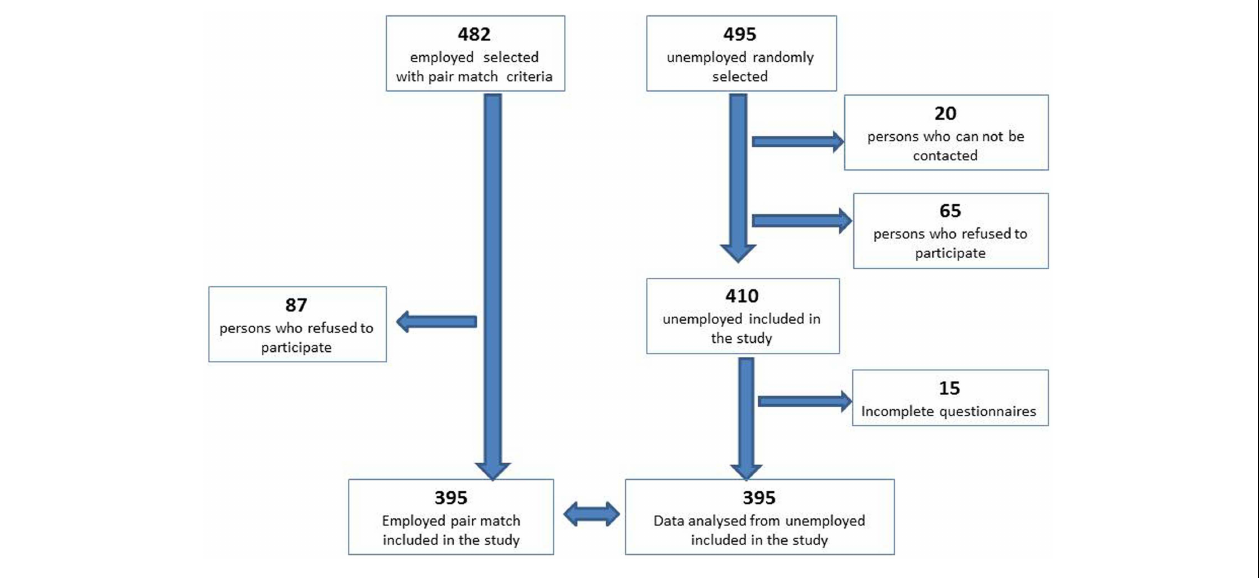
FIGURE 2 |The flowchart of recruitment